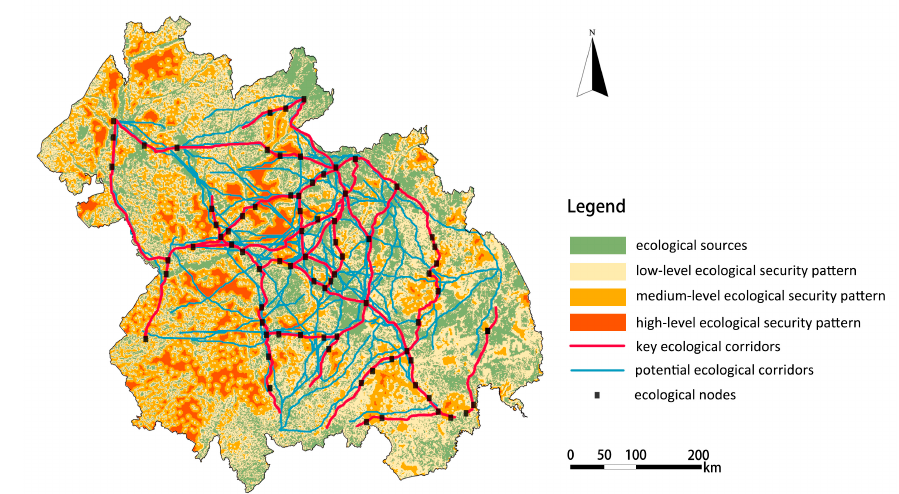
Figure 7. The ESP map of Harbin-Changchun urban agglomeration.